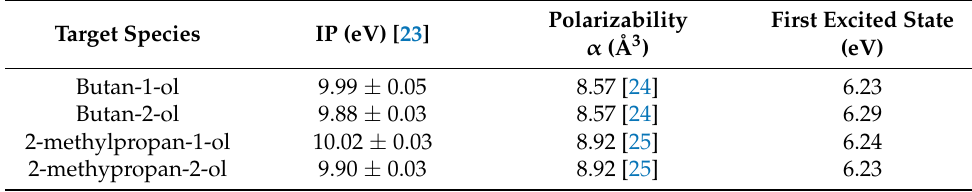
Table 1. Target properties (butanol